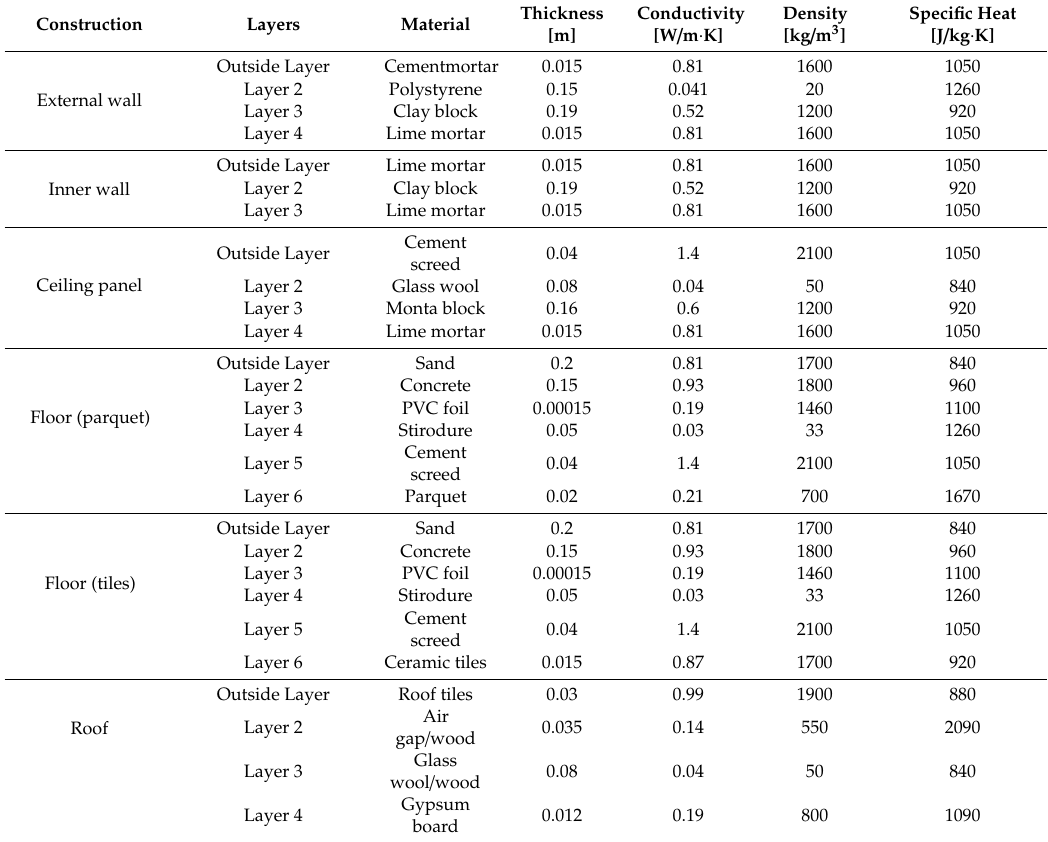
Table 1. Materials used in the envelope of the buildings.